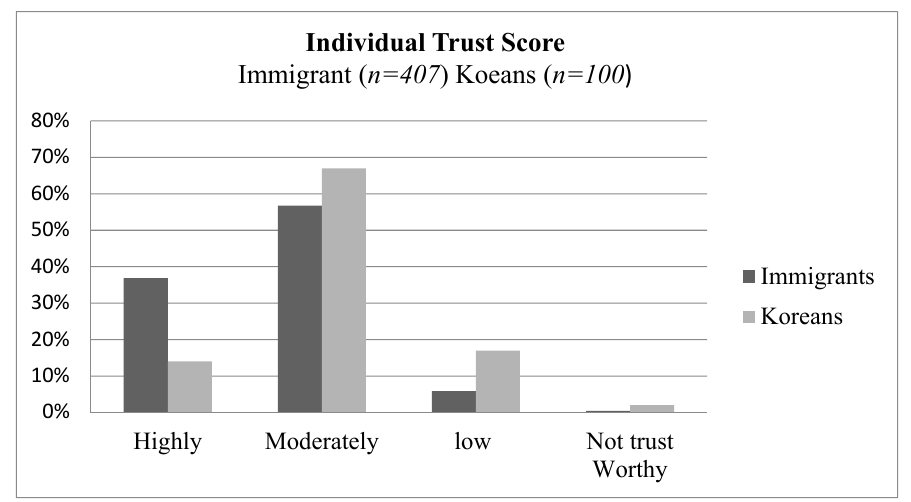
Figure 2. Average trust score ( n = 407) and Koreans ( n = 100). As it is displayed in figure 3, the Individual-level of trust, the mean scores of trust in the health system, nearest health institutions, and local media were higher in the immigrant group. However, the mean score of the trust level on the local community is greater in the native Korean group. The overall mean scores in both groups indicate a higher level of trust in the mentioned institutions and the local native community (M ≥ 2.0).